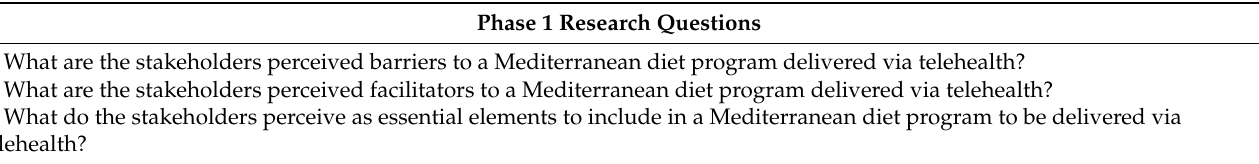
Table 1. Research Questions Resulting from Phase